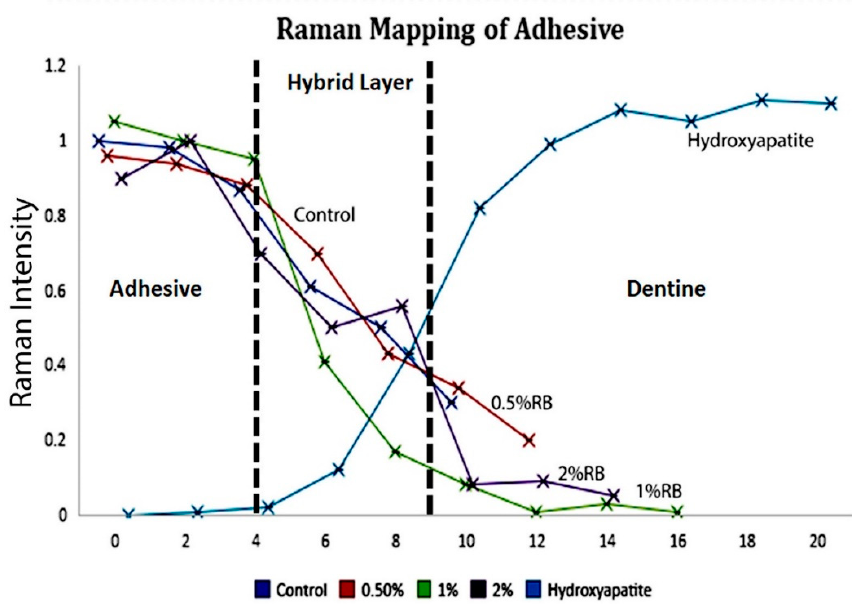
Figure 2. Representative line map (scans) across resin–dentin interface of different control and RB- modified adhesive specimens are shown. The spectral contribution is recorded at 960 cm − 1 (hydroxyap- atite) and 1450 cm − 1 (C-H alkyl) intensities representing the penetration of different adhe- sives.